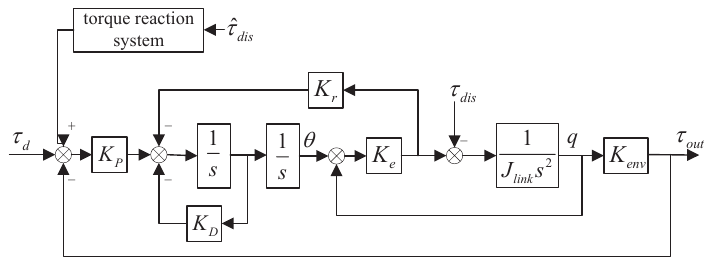
Figure 10. Non-linear disturbance compensation on the link